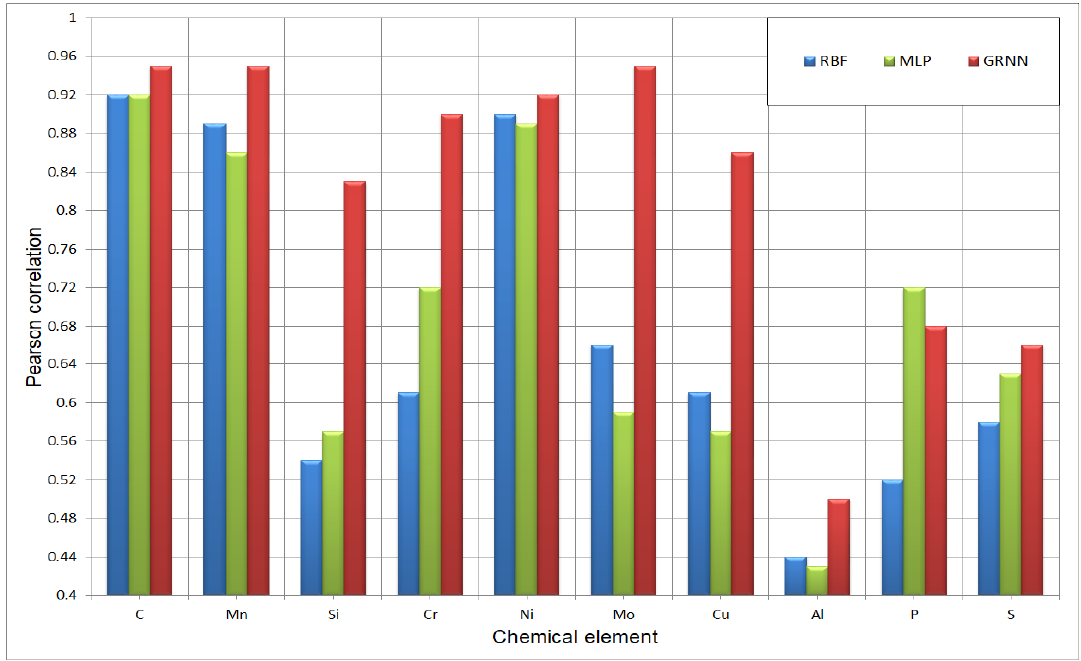
Figure 1. Comparison of Pearson correlation for the best achieved artificial neural networks (testing set), built for examinate steels.